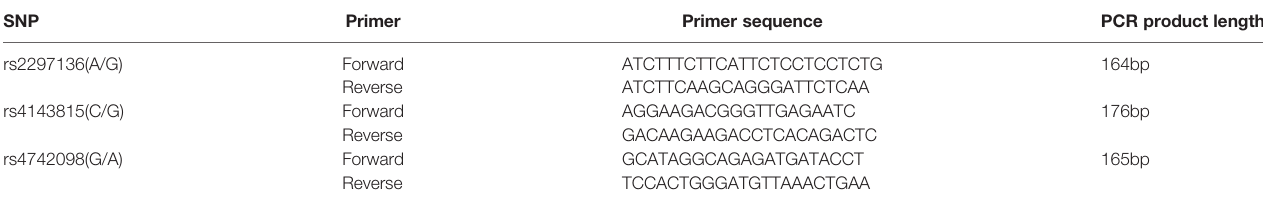
SNP: single nucleotide polymorphism; PCR: polymerase chain